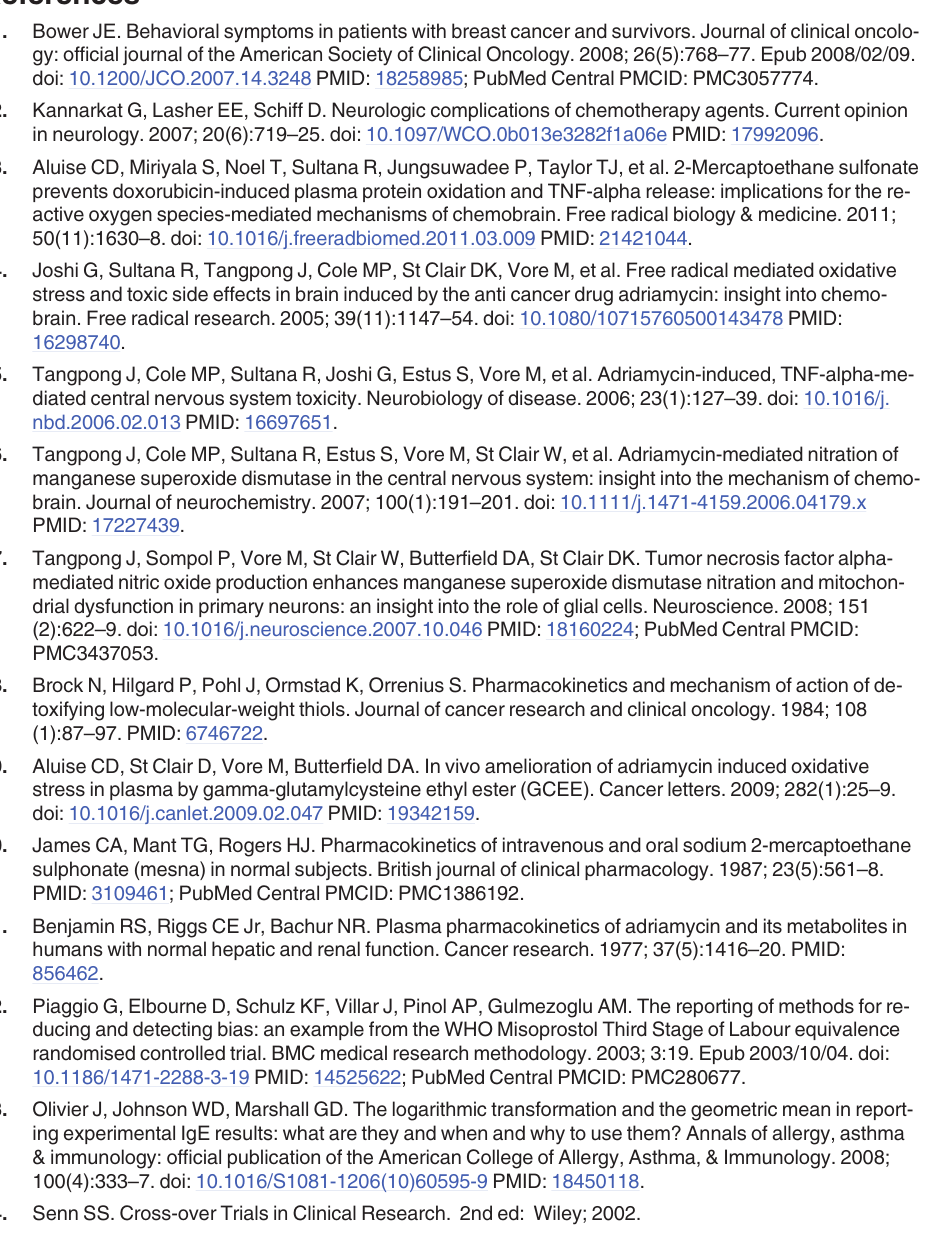
S4 Table. All toxicities regardless of attribution split by treatment and